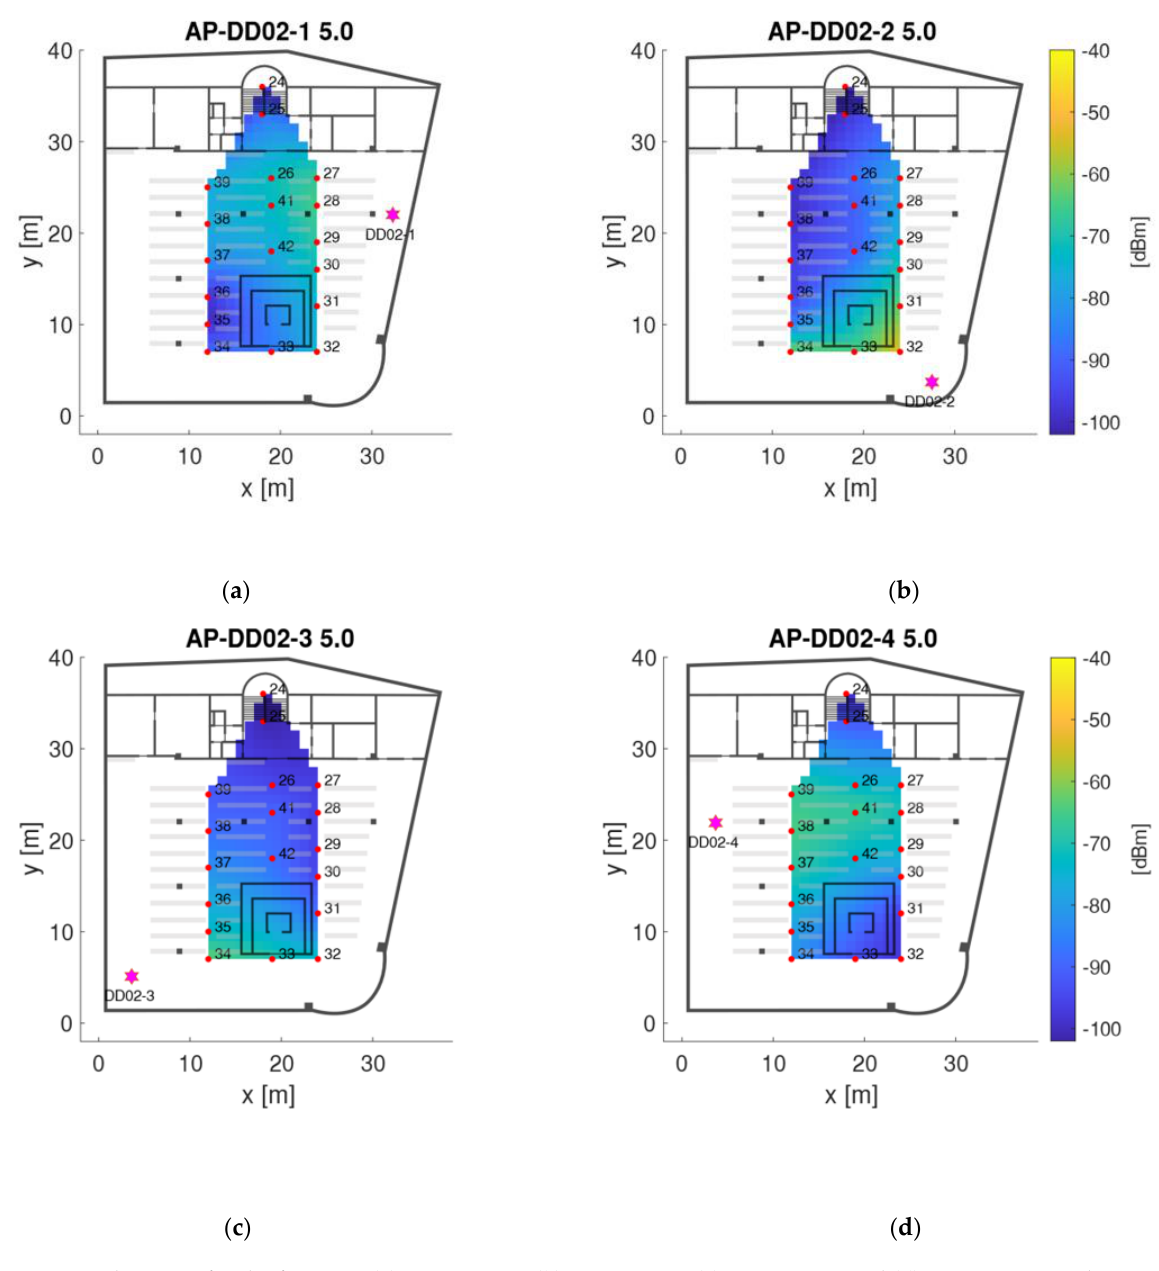
Figure 7. Radio maps for the two APs ( a ) AP-DDEG-1 and ( b ) AP-DDEG-2 on the ground floor of the library.